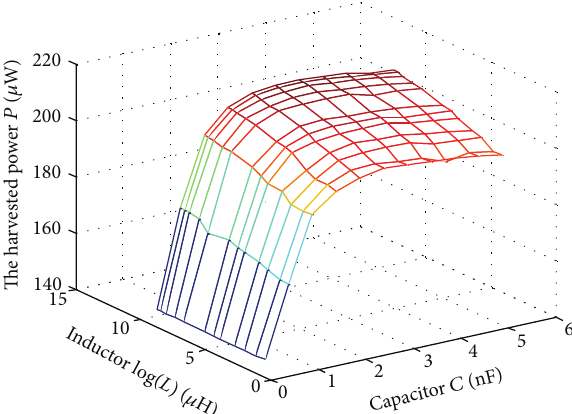
Figure 11: 3D plot of the harvested power with 𝐶 and 𝐿